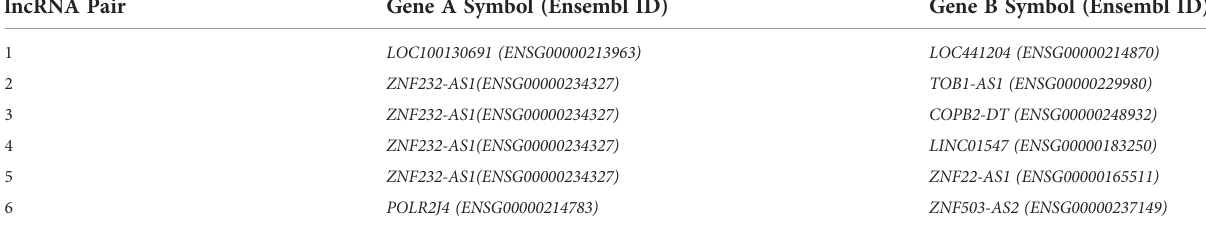
TABLE 2 Six candidate diagnostic long non-coding RNA (lncRNA) pairs for colorectal cancer (CRC). In each lncRNA pair, gene B always has a higher expression level than gene A in CRC tissue samples compared with non-CRC tissue samples. If at least three of the six lncRNA pairs showed that the expression level of gene A is less than gene B, the tested sample was predicted as cancer. lncRNA Pair Gene A Symbol (Ensembl ID) Gene B Symbol (Ensembl